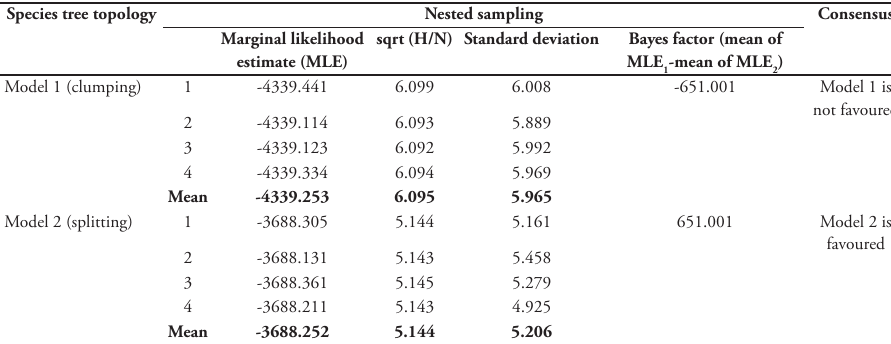
Table 5. Nested sampling analysis results on two competing topology models for combined 12S rRNA and TYR using calibrated species trees. The values include summation of estimated Marginal L value with calculated Bayes factor for designated topology Model 1 and model 2. The positive value favoured the designated model. Topology Model 1 clumped Kurixalus idiootocus and K. inexpectatus sp. nov. as a single species. Topology Model 2 proposed K. inexpectatus sp. nov. as a new species and split from K. idiootocus . Bold values indicate the mean of nested sampling for each